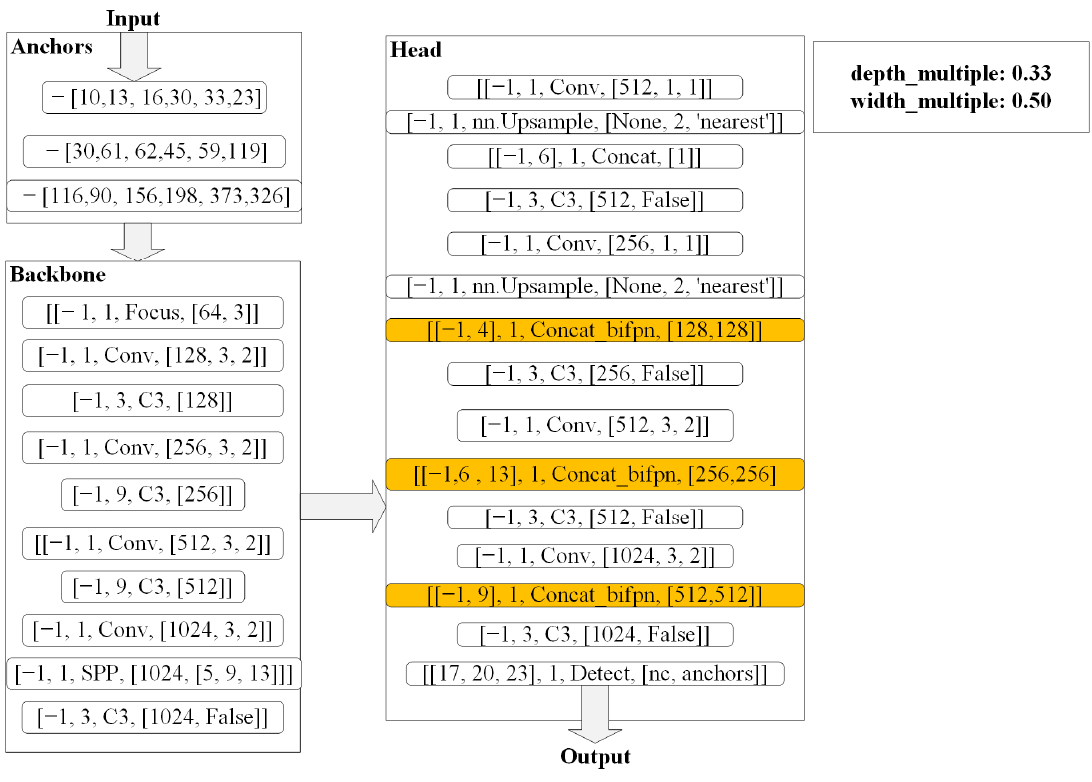
Figure 2. The detailed processing flow of the BV-YOLOv5S model to realize road defect detection. (Depth_multiple and width_multiple are the depth and width of the network, respectively. The anchor part is the size setting of the anchor. The content expression format of the backbone part [number, module, args] were from the input of the layer, where number is the number of the layer, module is the class name, and args is the initialization parameter of the class. The head part is the same as the backbone part in terms of content expression format).